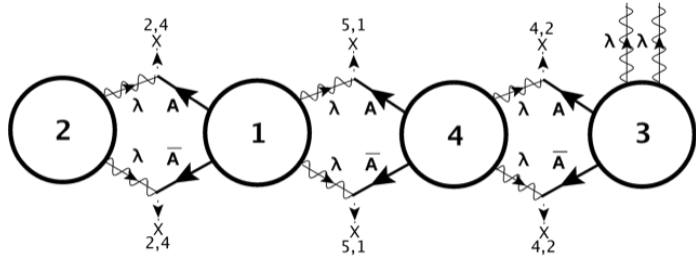
Figure 3: A sketch of the four monopole composite contributing to the superpotential × SU ( 2 ) in the low-energy SU ( 2 ) . The antisymmetric VEVs are represented by a a b cross with their color